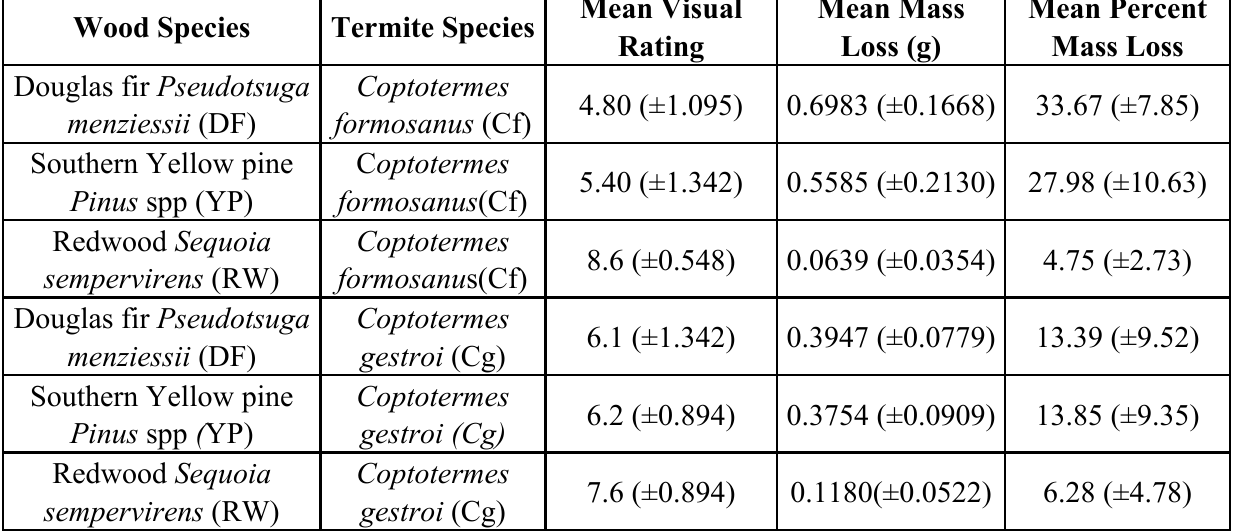
Table 1. Summary of results for C. formosanus and C.gestroi from multiple-choice test. Rating: 10 (sound), 9.5 (trace, surface nibbles permitted), 9 (slight attack up to 3% of cross sectional area affected), 8 (moderate attack, 3–10% of cross sectional area affected), 7 (moderate/severe attack, penetration, 10–30% of cross sectional area affected), 6 (severe